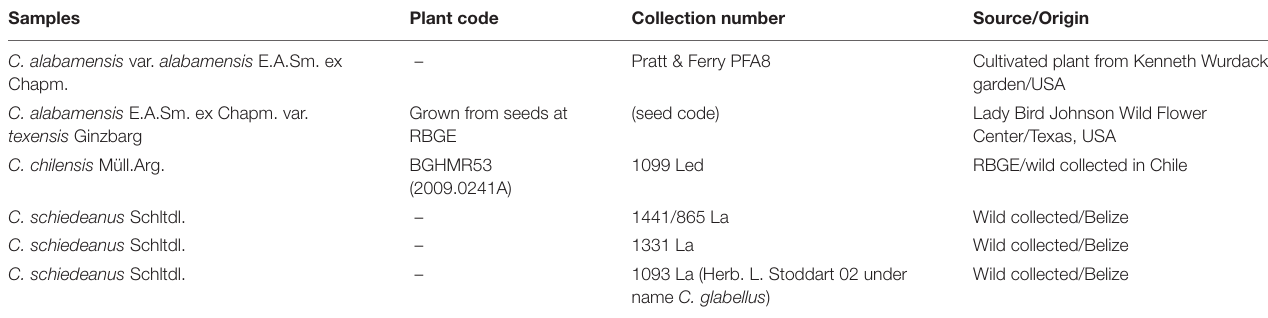
TABLE 1 | Origin of samples of Croton used in this